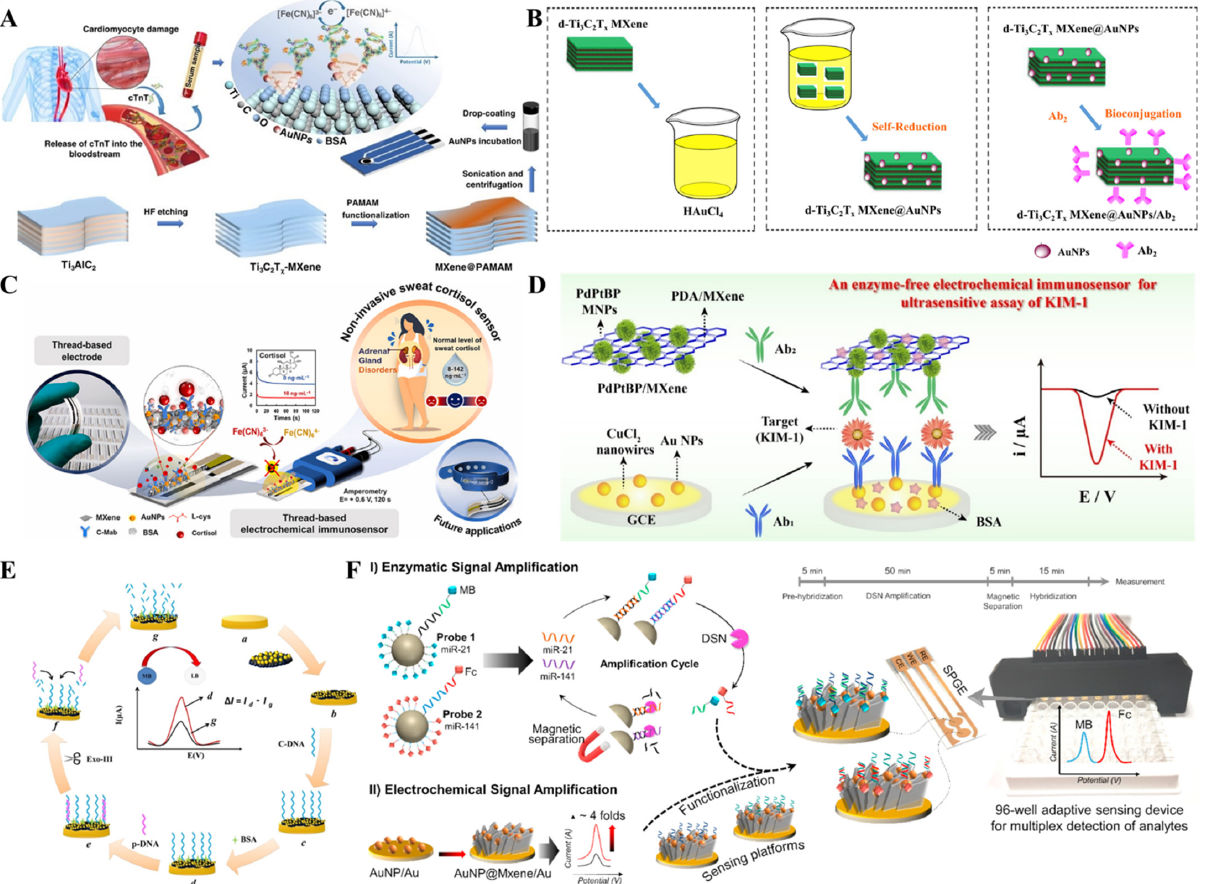
Figure 18. ( A ) Schematic illustration of the fabrication of AuNPs/MXene@PAMAM for the electrochemical detection of cTnT. Reproduced with permission from Ref. [108] . Copyright 2022, Nature. ( B ) Preparation of d-Ti 3 C 2 MXene@AuNPs/Ab2 for the detection of PSA. Reproduced with permission from Ref.